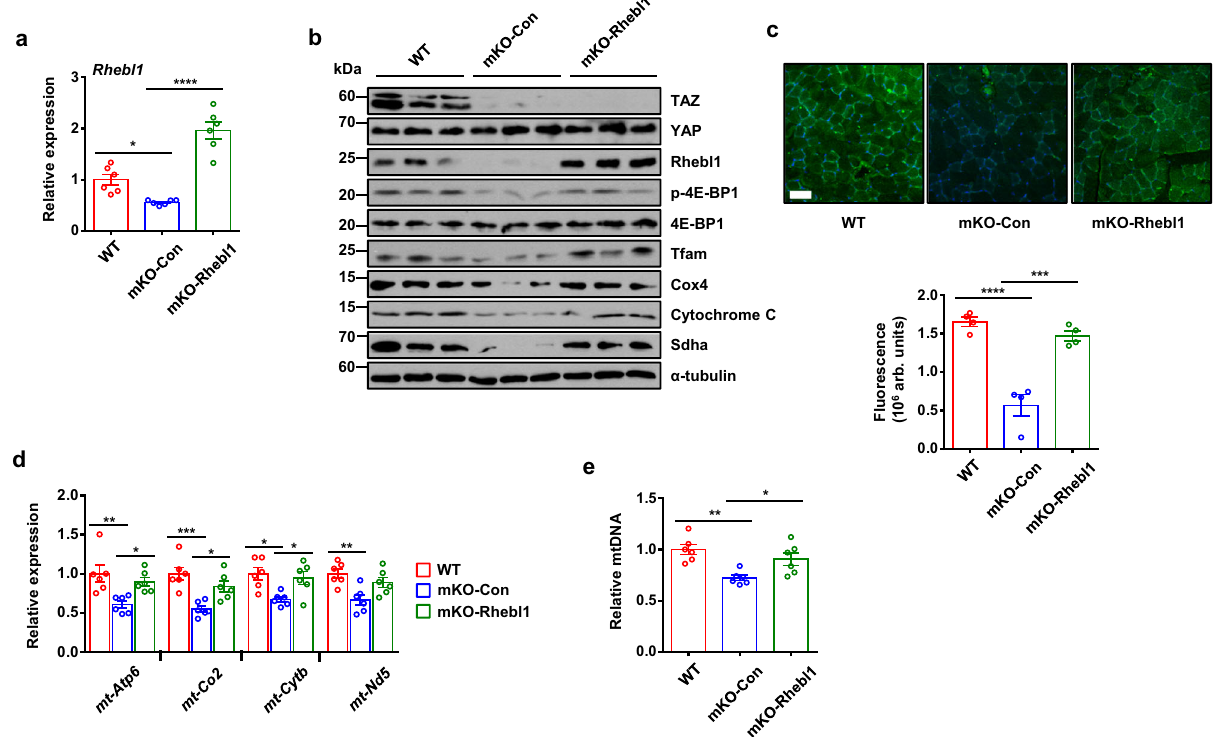
Fig. 4 Rhebl1 re-introduction restored mitochondrial biogenesis in muscle-speci fi c TAZ knockout mice. a RNA was isolated from gastrocnemius muscle of wild type (WT) and muscle-speci fi c TAZ knockout (mKO) mice intramuscularly transduced with pAAV6-CMV (mKO-Con) or pAAV6-Rhebl1 (mKO- Rhebl1) virus. Levels of Rhebl1 transcripts were analysed by quantitative reverse transcription (qRT-PCR) to con fi rm Rhebl1 rescue. n = 6 for each